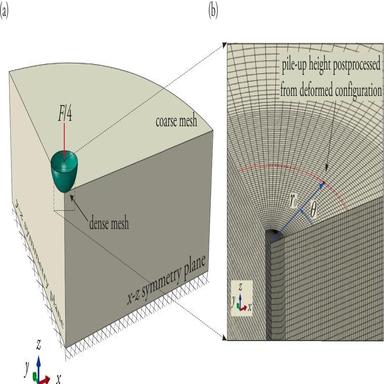
Numerical model for out-of-plane properties identification: (a) a quarter model with the cylindrical shape of the computation domain. The indenter is modelled as an analytical surface. The reduced size of the region was chosen to increase the efficiency of the simulation while not affecting the simulation results. (b) the mesh of the sample, for which a denser mesh is used in the contact region and at the location of the expected pile-up. The vertical displacements at the characteristic locations are interp